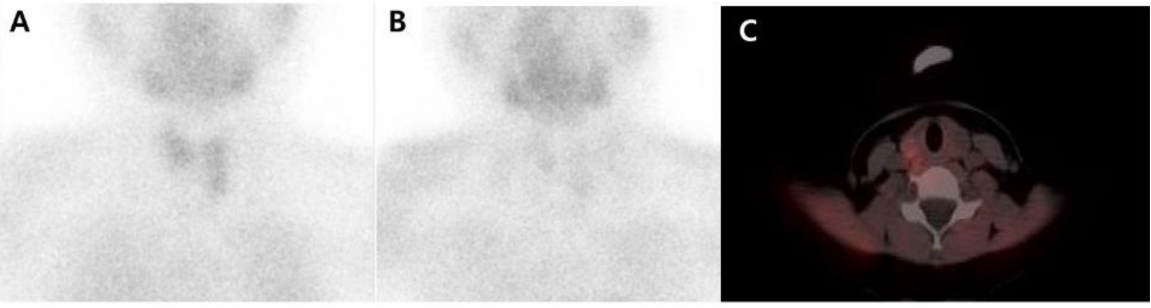
Figure 2. Subsequently, a 99m Tc-sestamibi scan was performed at 20 min ( A ) and 150 min ( B ) after radiopharmaceutical injection. There was no abnormal remaining radiotracer uptake lesion suggestive of parathyroid adenoma. Subsequent single photon emission computed tomography/computed tomography (SPECT/CT) ( C ) did not provide additional evidence of parathyroid